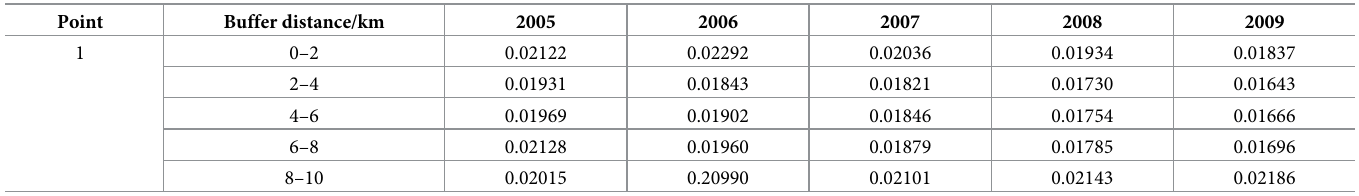
Table 7. Annual average VSWI values in different radiation radii of each interchange node of Yongjin Expressway before and after its construction(Show only part, S4 Table for complete table).